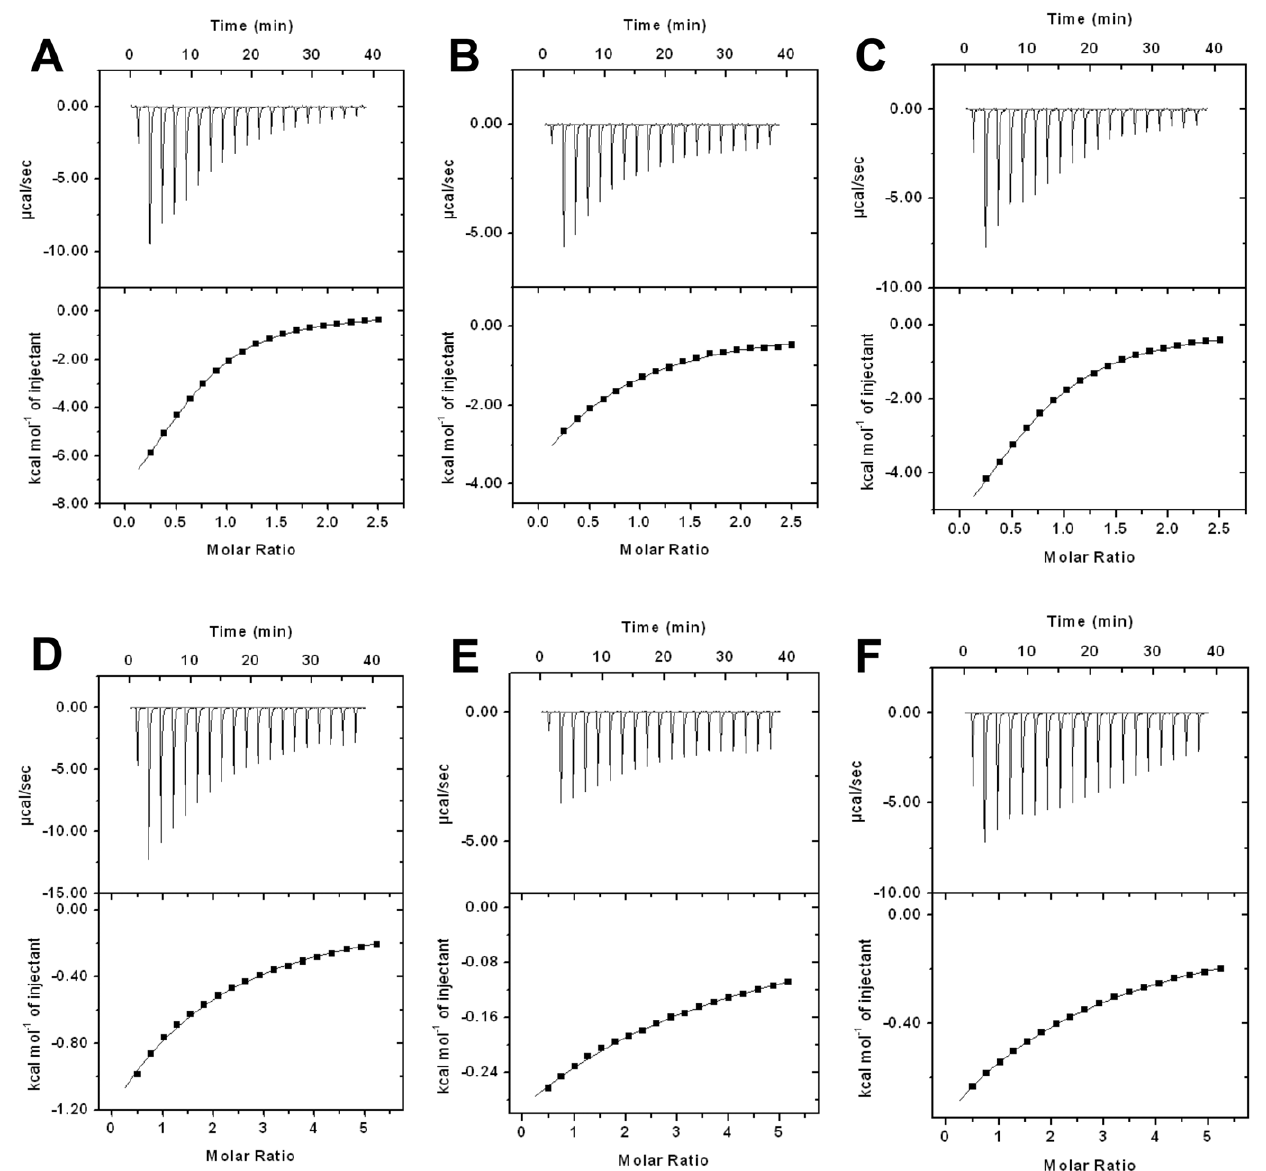
Figure 5. ITC binding assay of wildtype IPO (tetremeric IPO) with carbohydrates. For the methylated carbohydrates, the thermal changes were detected with 1 mM wildtype IPO which was titrated by 25 mM Me-Man ( A ), 25 mM Me-Glc ( B ), 25 mM Me-Gal ( C ). For the non-methylated carbohydrates, the thermal changes were detected with 3 mM IPO which was titrated by 75 mM Man ( D ), 75 mM Glc ( E ) and 75 mM Gal ( F ). The upper panel of figures was presented by 18 injections and 2 m l/per injection. The interval of injection time is 180 sec. The 18 experimental data were almost fitted for a 1:1 binding model (one-site of fitting) with Microcal Origin 7.0 software (the bottom panel). In each bottom panel, X-axis indicates the molar ratio of protein-carbohydrate and Y-axis indicates the thermal change in each